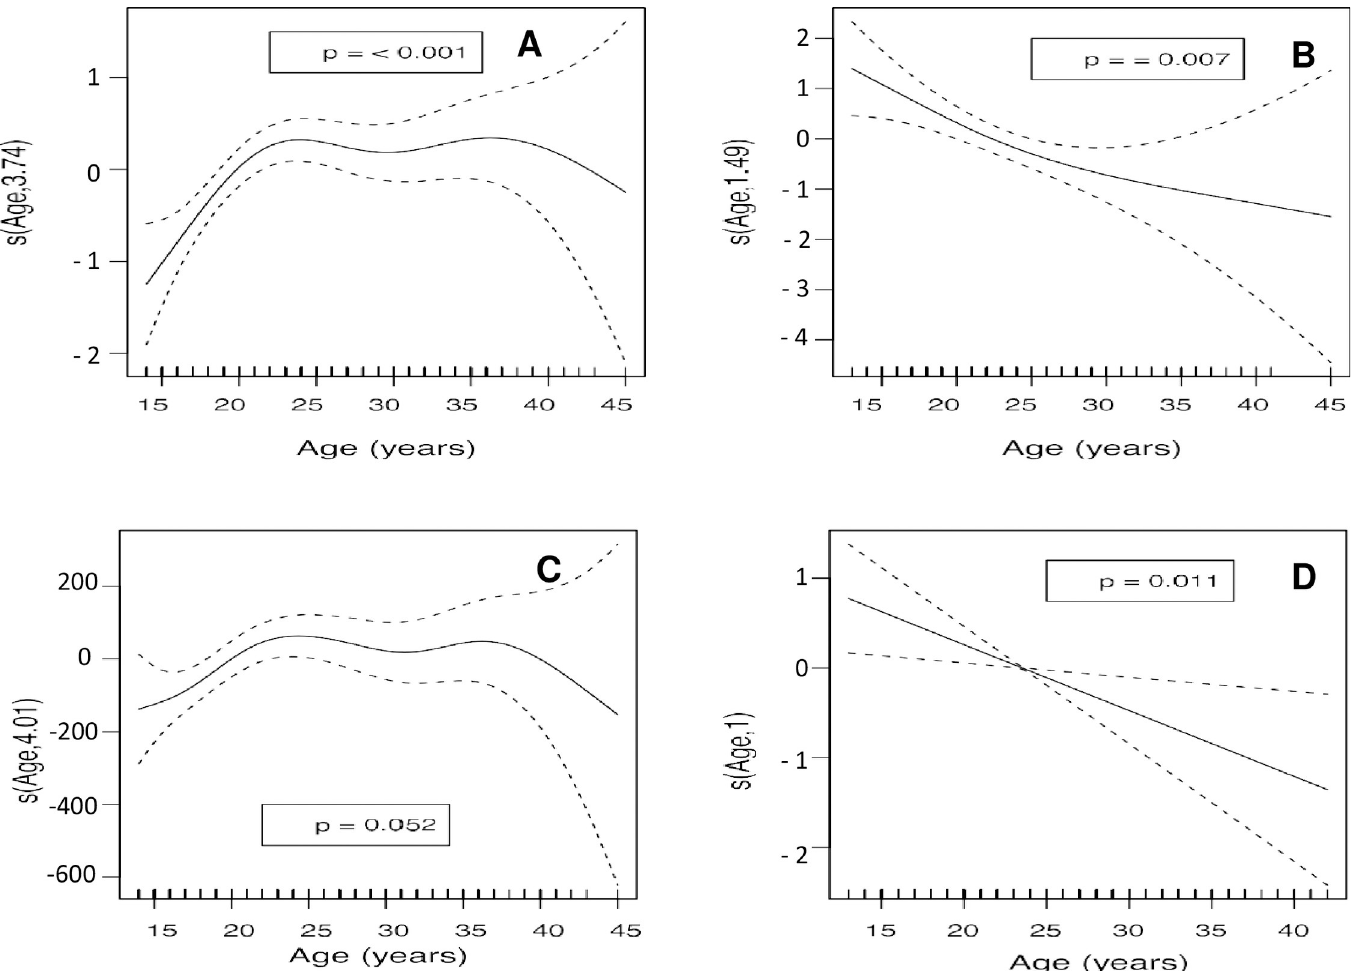
Fig 4. Analysis of the age of the mother versus A) follow-up of the pregnancy, B) episiotomy, C) weight of the newborn. Adjusted to the gestation week, D) neonatal respiratory